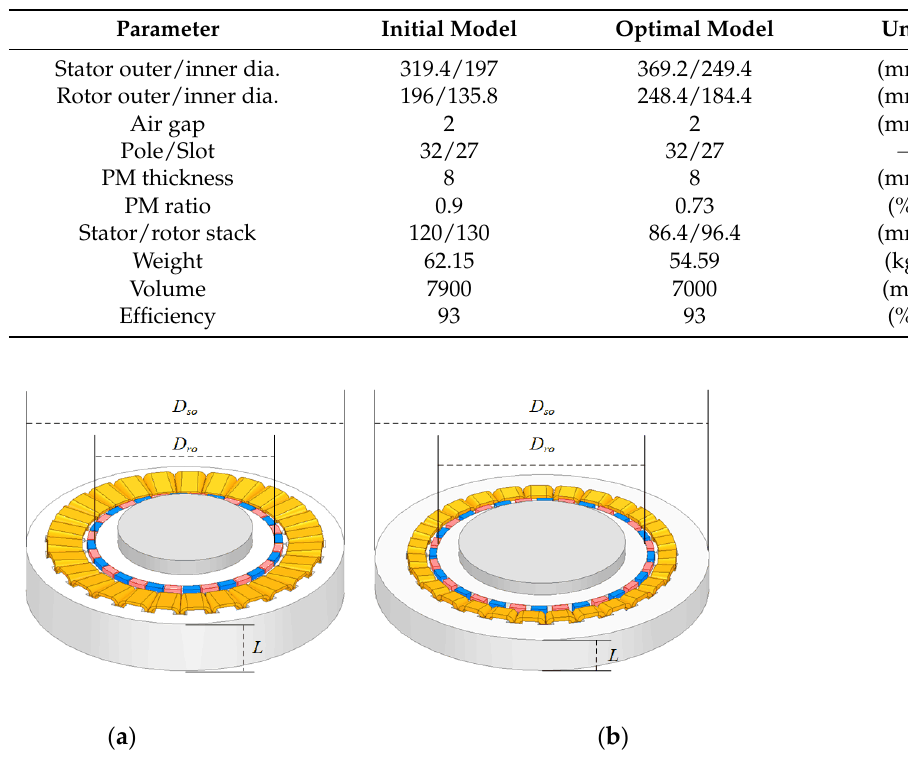
Figure 7. Comparison of 3D model through optimization algorithm: ( a ) initial 3D model, ( b ) opti- mized 3D model.